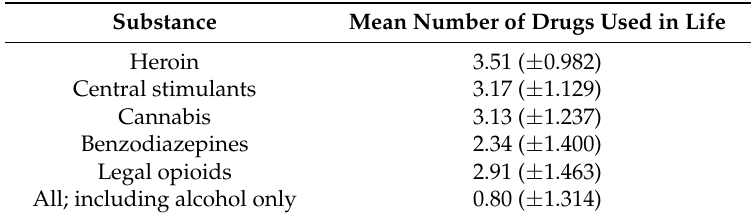
Table 2. Mean number of drugs misused in life by each drug used in life. Alcohol excluded.